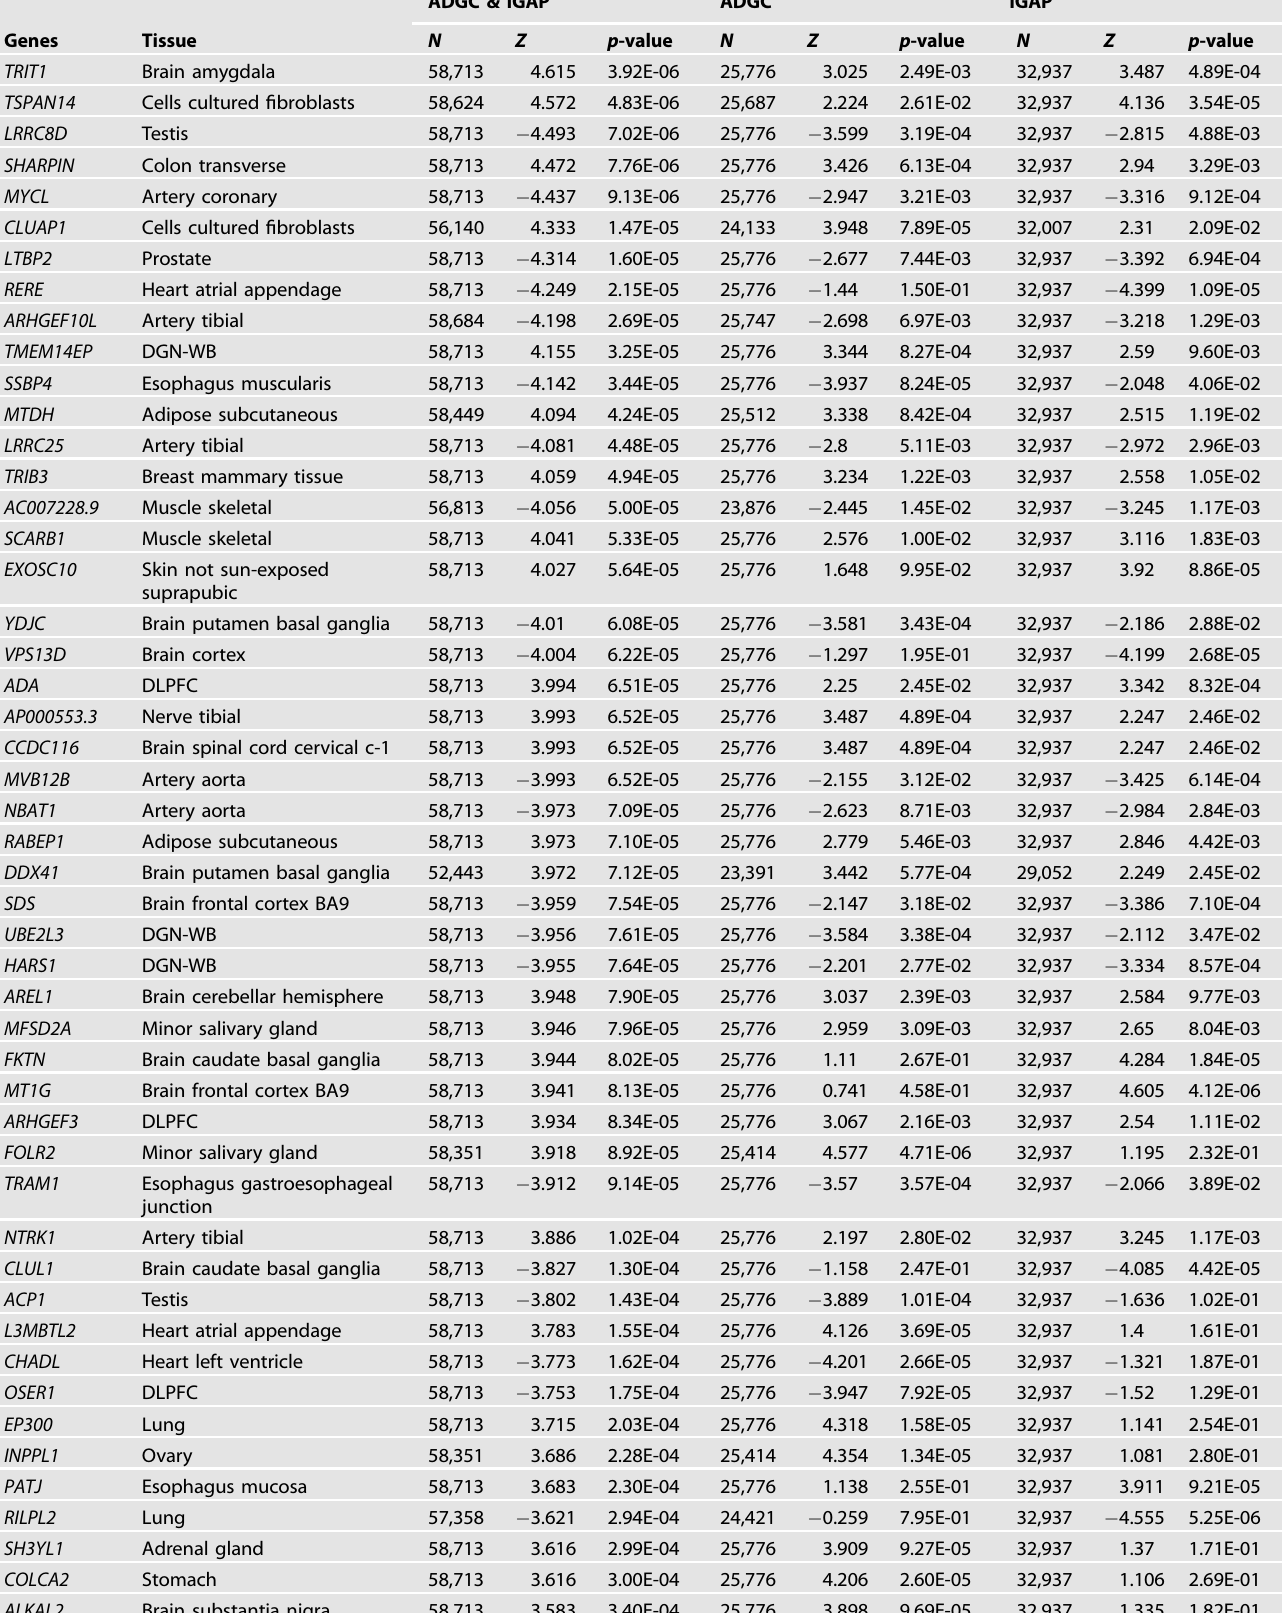
Table 1. Strongest tissue-speci fi c associations of novel LOAD